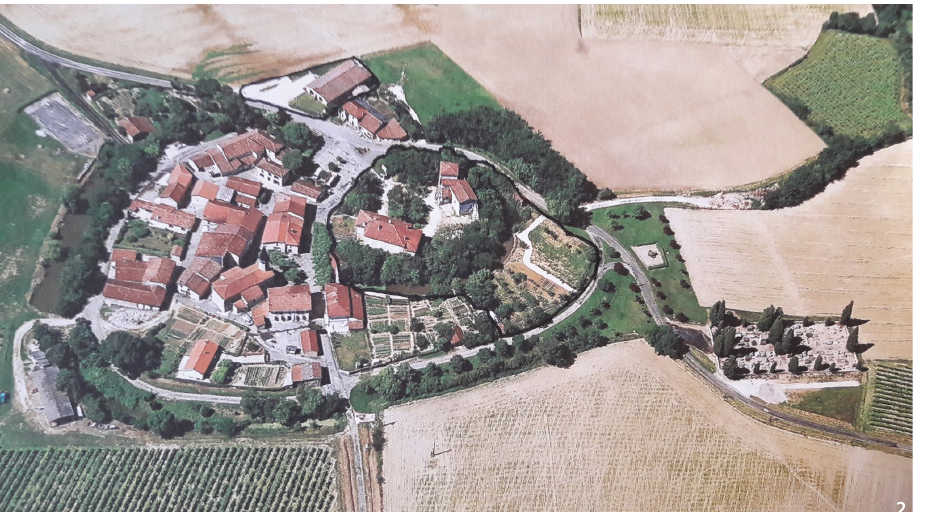
Figure 2 Centre village of the high-range hotel (Source: CAUE of